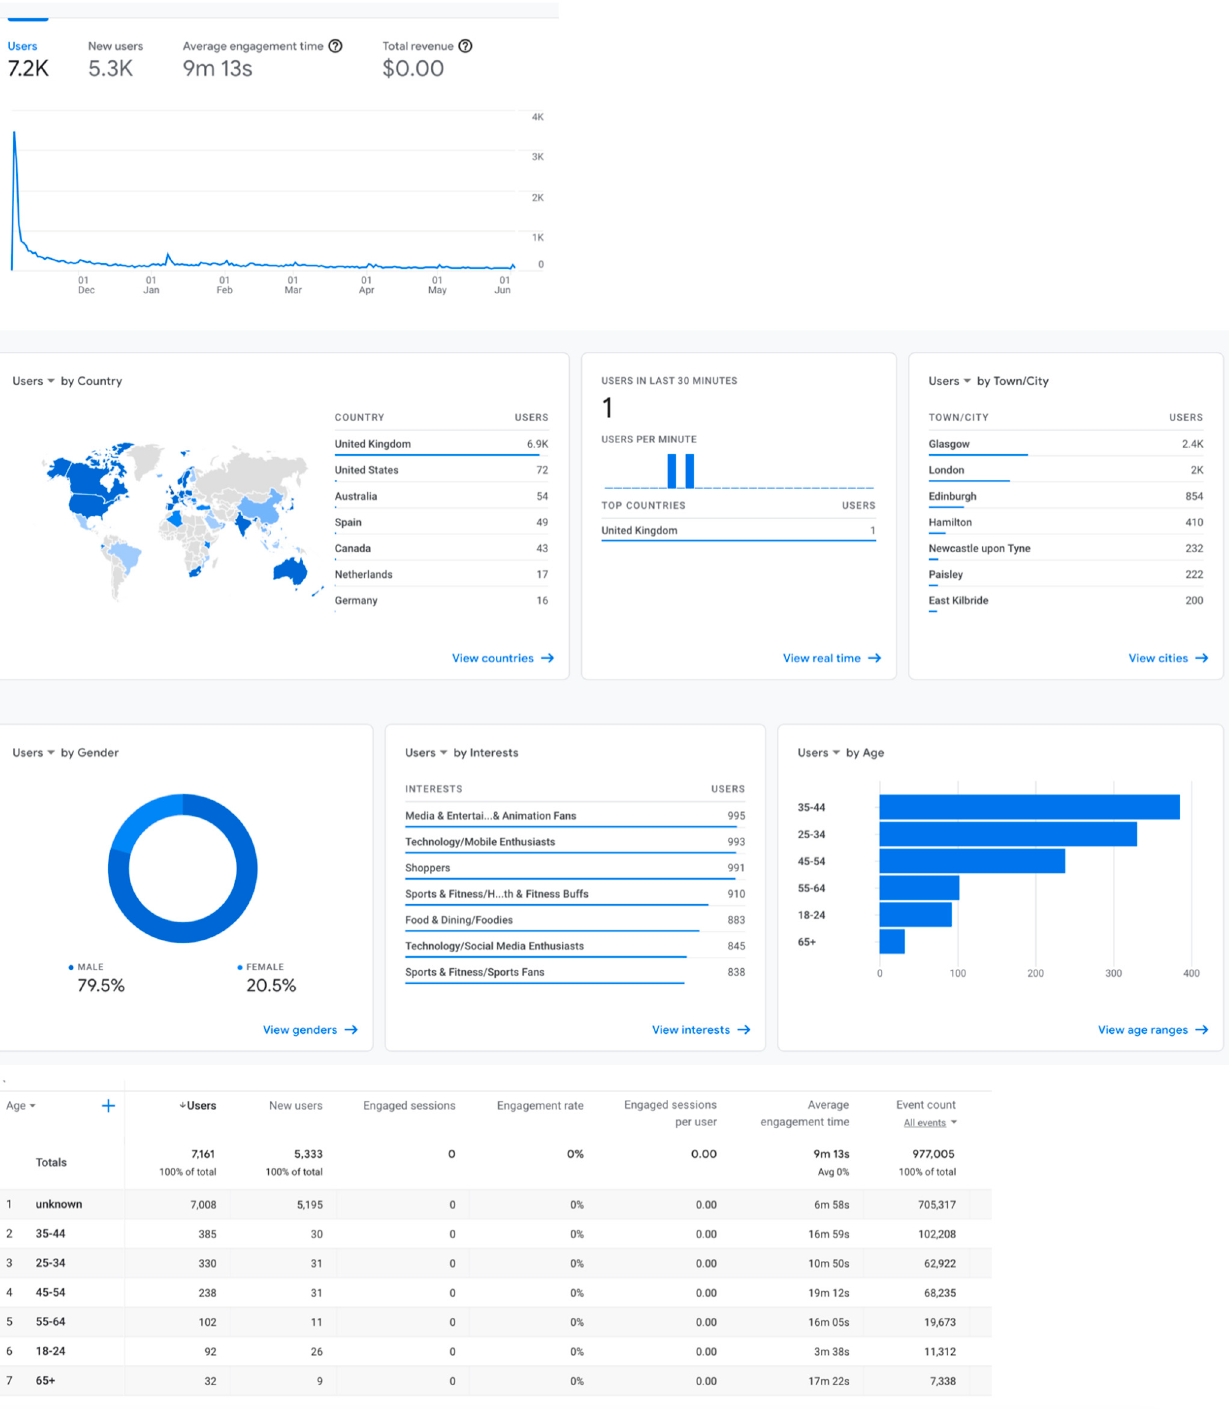
Figure A1. Fitbears Google Analytics between 3 November 2019 and 3 June 2020.